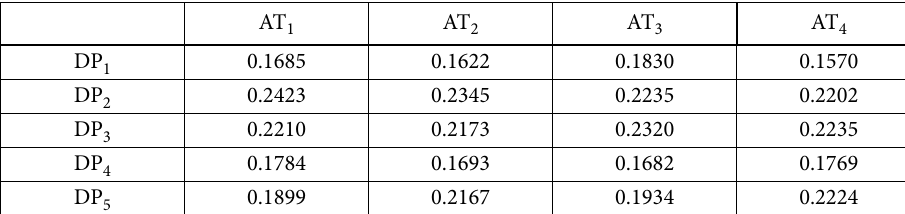
Table 10. The prospect weight of each alternative based on e 3 AT 1 AT 2 AT 3 AT 4 DP 1 0.1685 0.1622